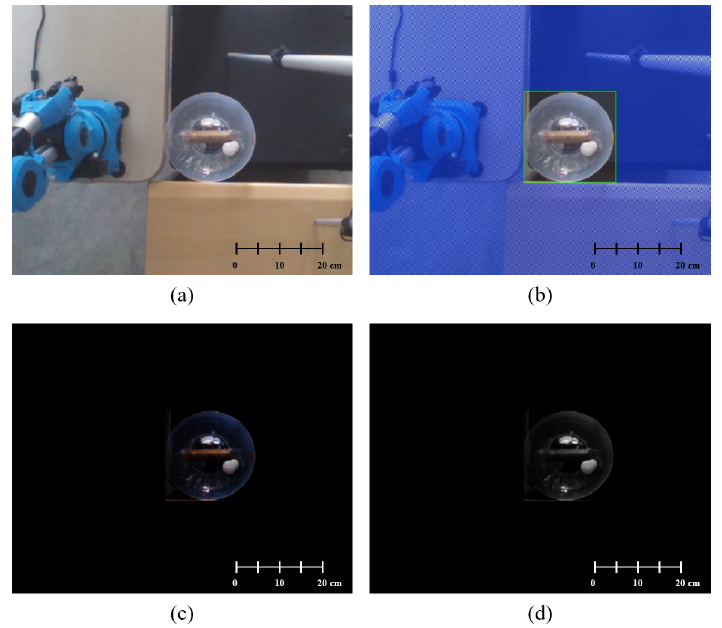
Figure 5. Example of RGB image processing: ( a ) RGB image is obtained, ( b ) ROI is selected, ( c ) brightness, gamma, and contrast are adjusted, and ( d ) it is converted into a grayscale image.